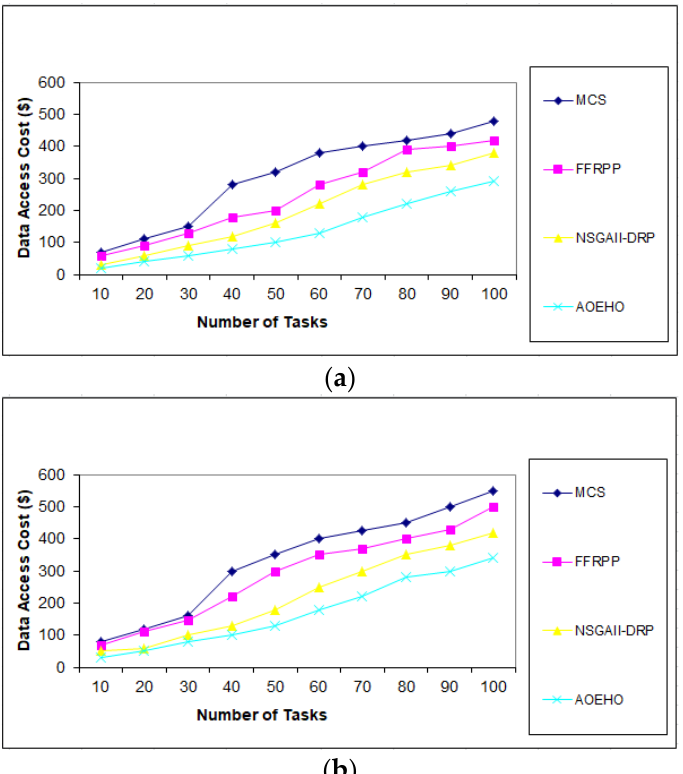
Figure 2. Cost number of tasks and cost = 100 tasks. ( a ) Size of data replication = 64 MB. ( b ) Size of data replication = 320